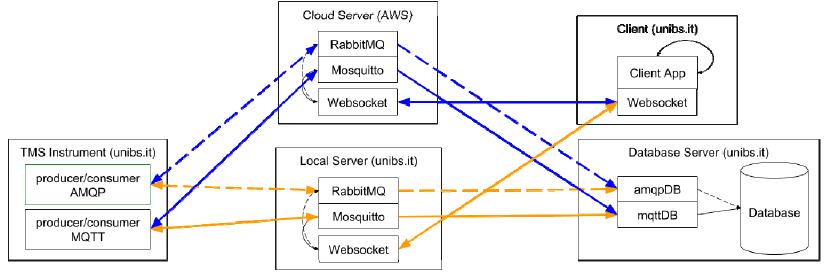
Figure 7. Block diagram of the implemented experimental setup.